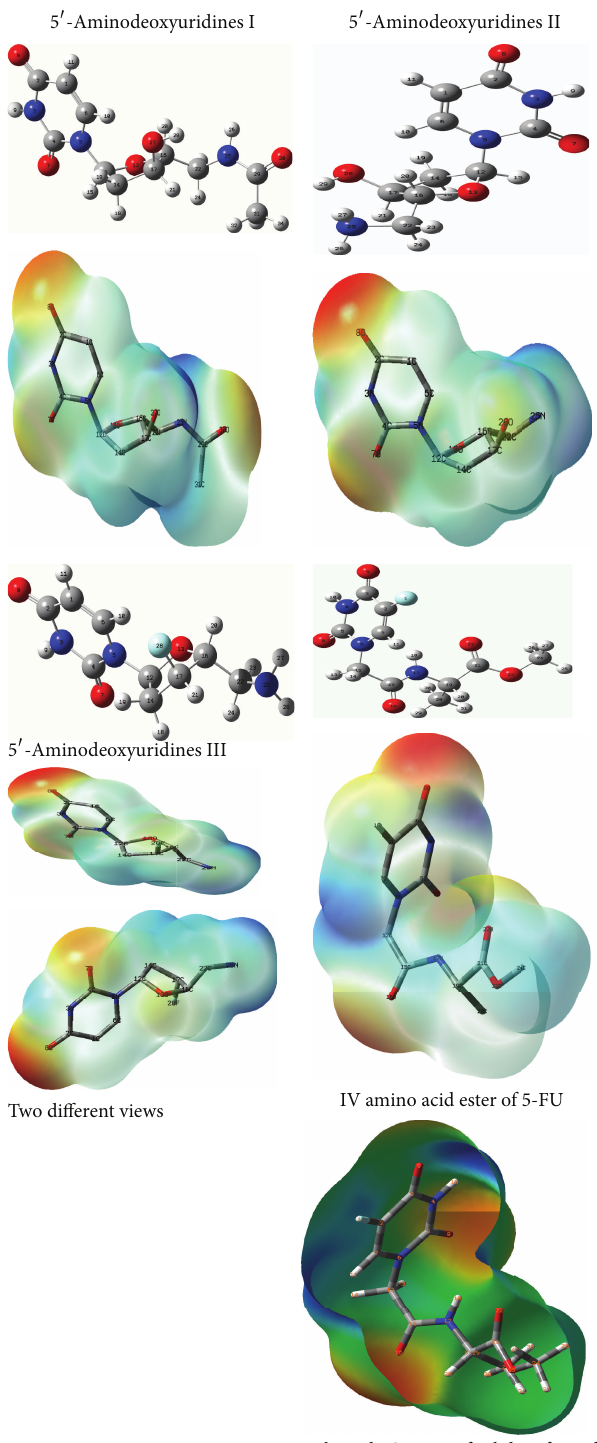
Figure 5: Transparent ESP map of uredines (I, II, and III) and amino acid ester of 5-FU (IV). Isovalue = 0.0004; ESP value ranges between − 140kJmol −1 (red) and +140 kJmol −1